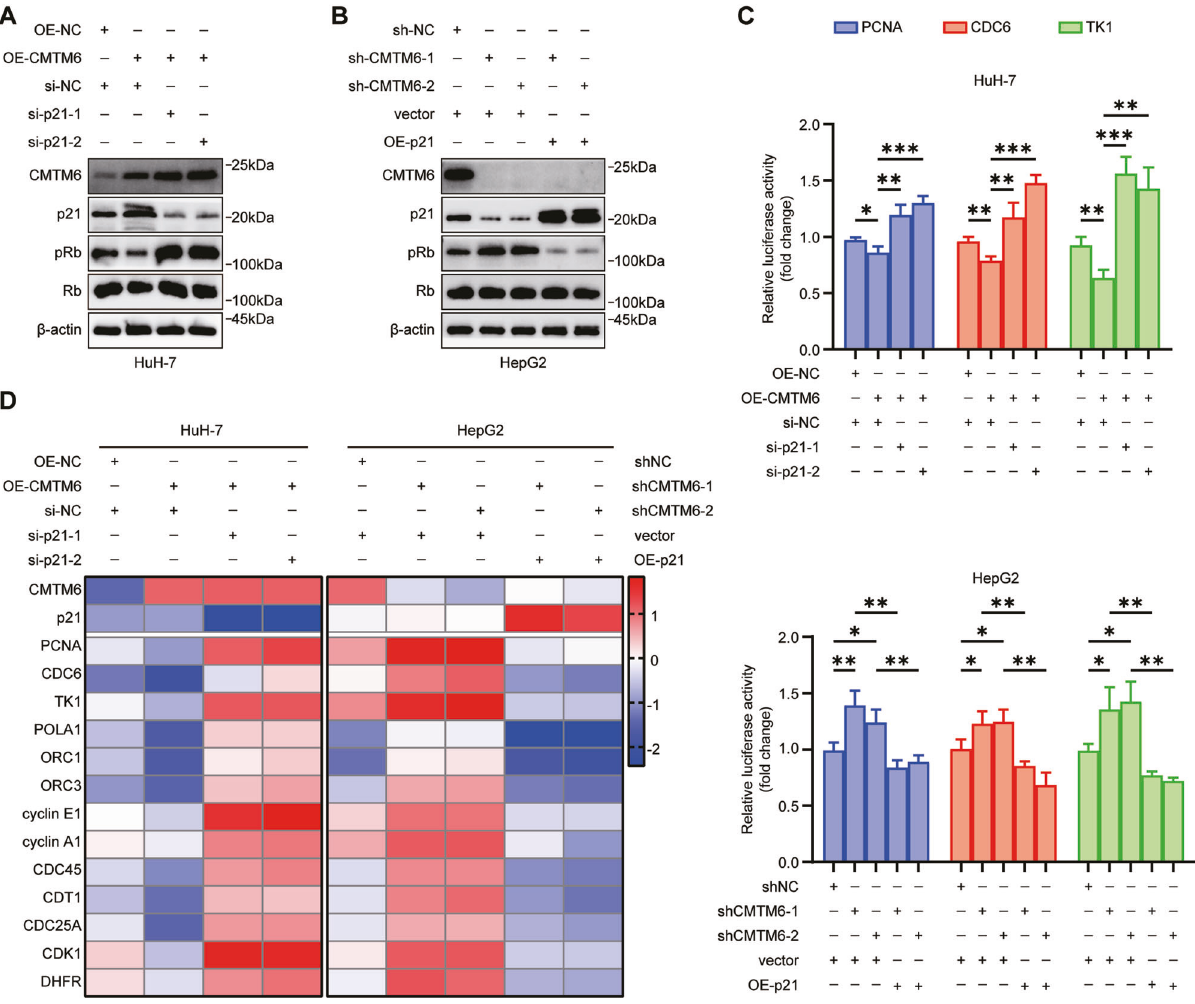
Fig. 6 CMTM6 reduced the phosphorylation of RB and downregulates E2F1 transcription factors activity. A The HuH-7 cells stably overexpressing CMTM6 were transfected with scramble or two independent p21 siRNAs. The expression of p21, pRB and total RB was detected by Western blot analysis. B The HepG2 cells with stable CMTM6 depletion were transfected with empty vectors or vectors expressing p21. The expression of p21, pRB and total RB was detected by Western blot analysis. C Dual-luciferase reporter assays revealing the transcriptional activity of E2F1 on the promoters of CDC6, PCNA and TK1 in the indicated cells. D qPCR analysis of the mRNA levels of the candidate downstream targets of E2F1 in the indicated cells. The error bars represent the mean ± SD. * P < 0.05; ** P < 0.01; *** P <